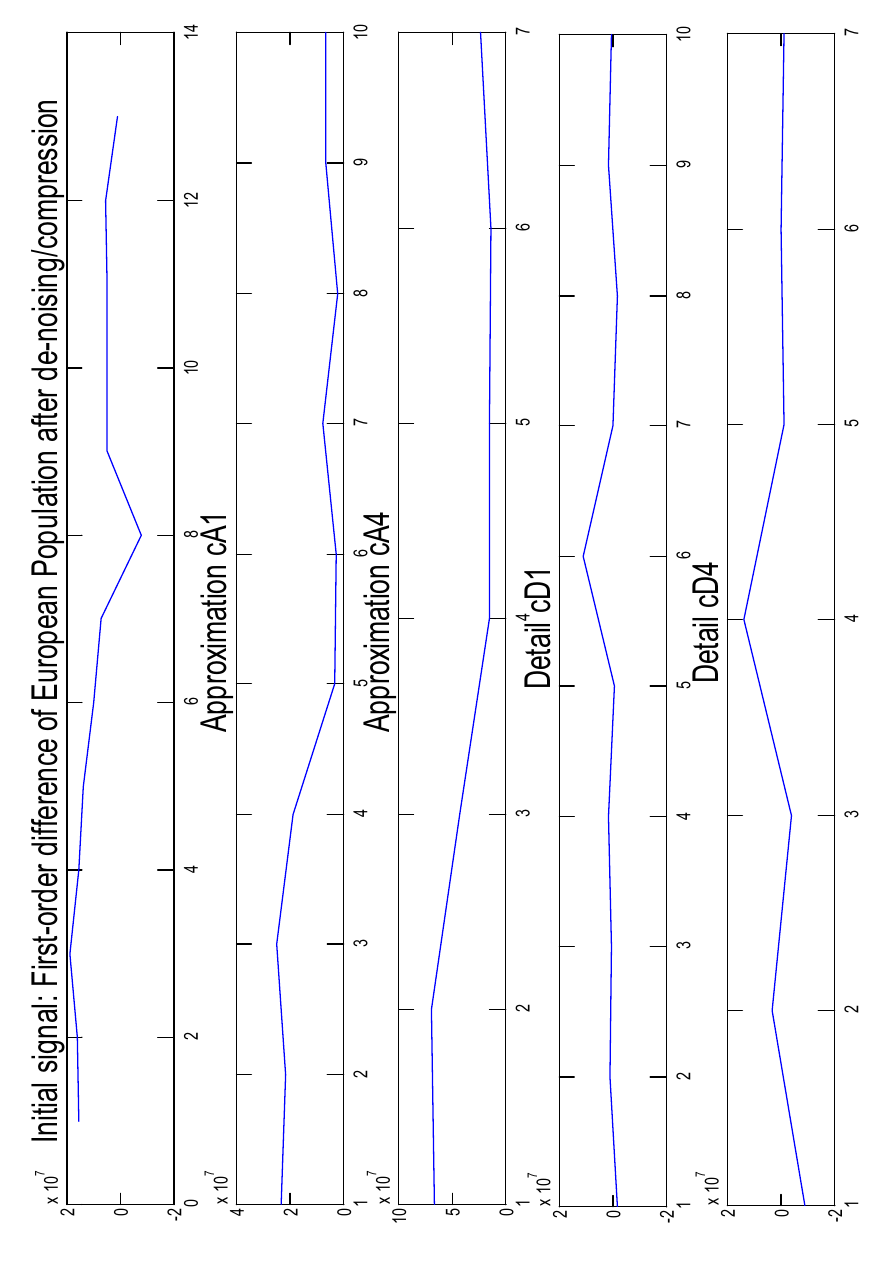
Figure 3. 4th-level decomposition of the transformed European total population, 30 countries, 13 data (after differentiation and de-noising/ compression) using one-dimensional discrete wavelet